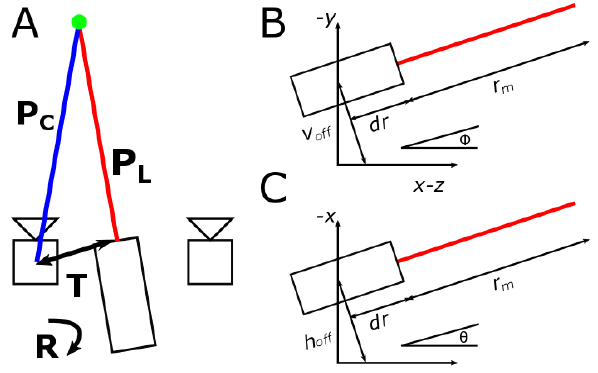
Figure 2 System geometry. A: relationship between stereo cameras and LIDAR for a single world point. B: side view of LIDAR. C: overhead view of LIDAR. Systematic angular offsets are not